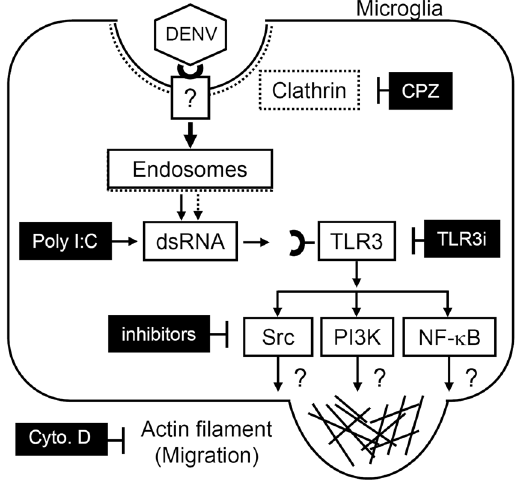
Figure 6. A hypothetical model of the DENV-induced increase in cell migration in microglia. Following infection through unknown receptor(s), DENV enters into microglial cells through clathrin-mediated endocytosis. dsRNA replication can activate the TLR3 signaling pathways to increase microglial